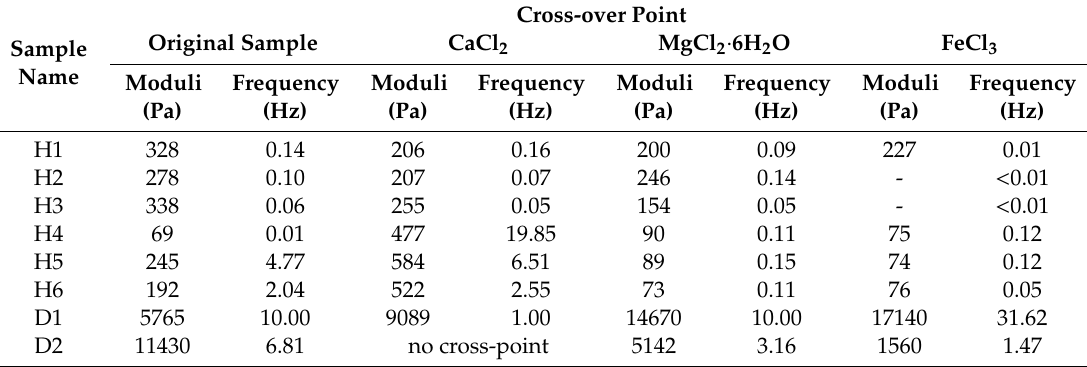
Table 5. The effect of multivalent ions to cross-over point in samples, values of frequency and G' = G".